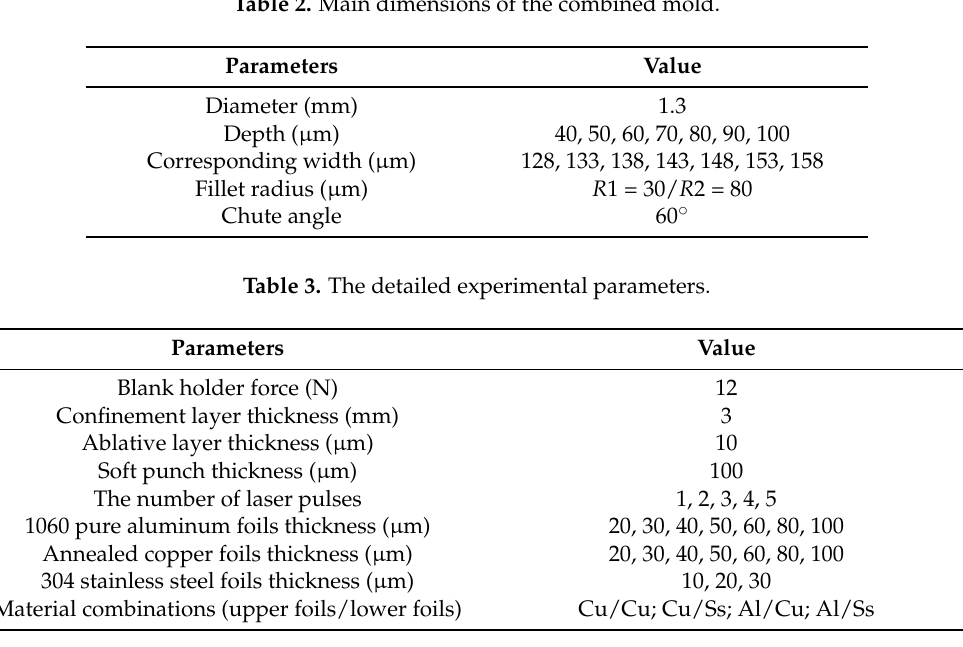
Figure 2. The combined mold: ( a ) the main dimensions ( h -the depth of the mold, d -mold diameter, w -the width of the chute); ( b ) real product photo; ( c ) local magnification of the mold slider. Table 2. Main dimensions of the combined mold.